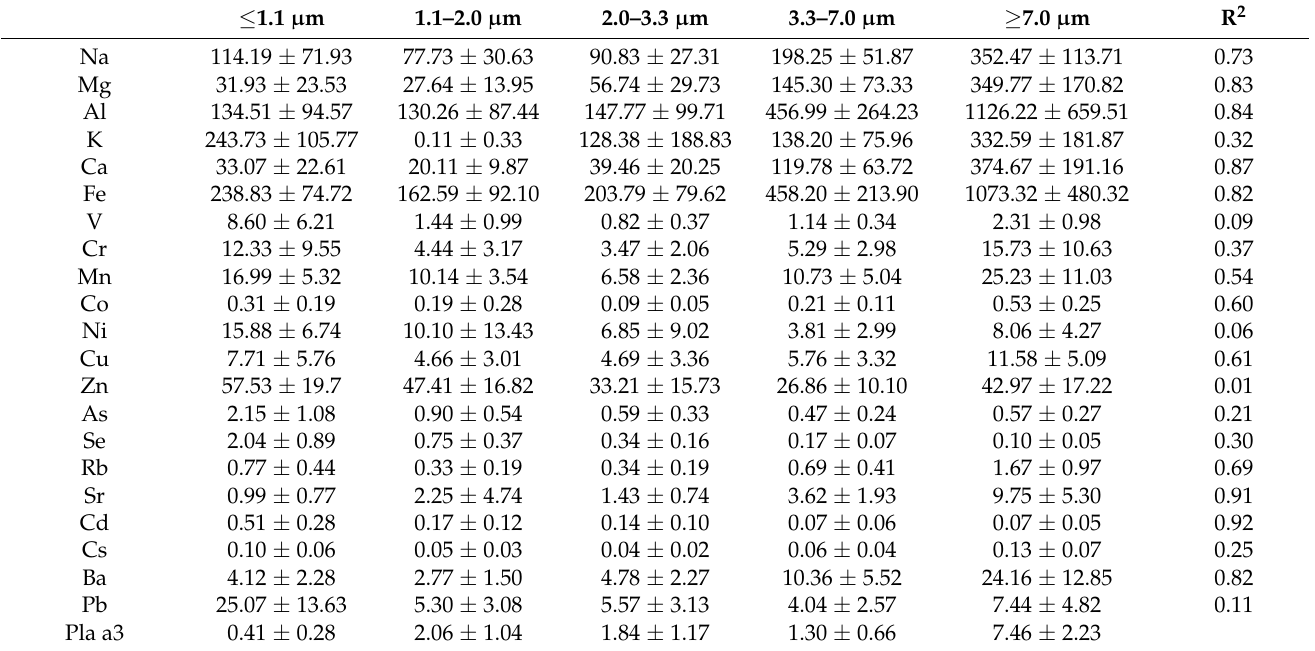
Table 1. Correlation coefficients between average mass level of chemical elements and mass concen- tration of Pla